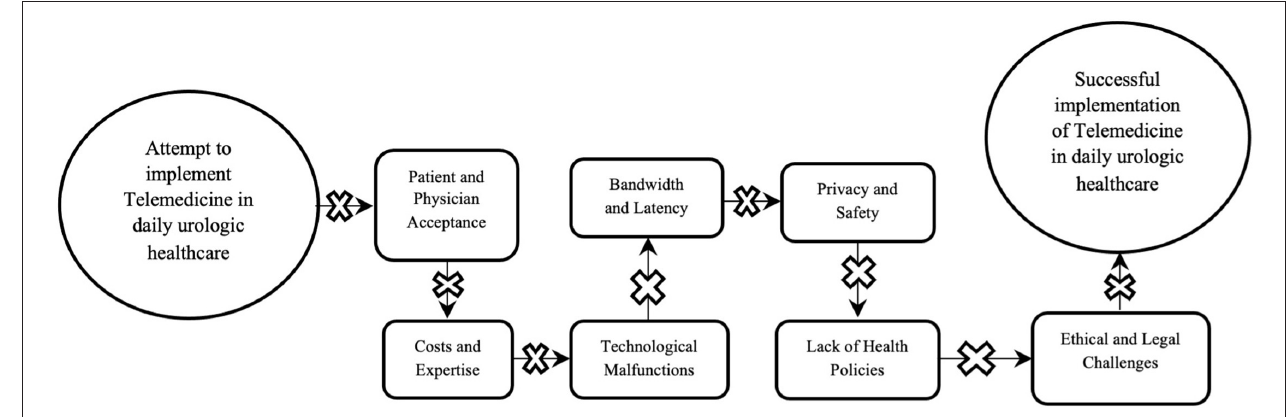
FIGURE 2 | Illustration depicting the obstacles of implementing telemedicine in urology.